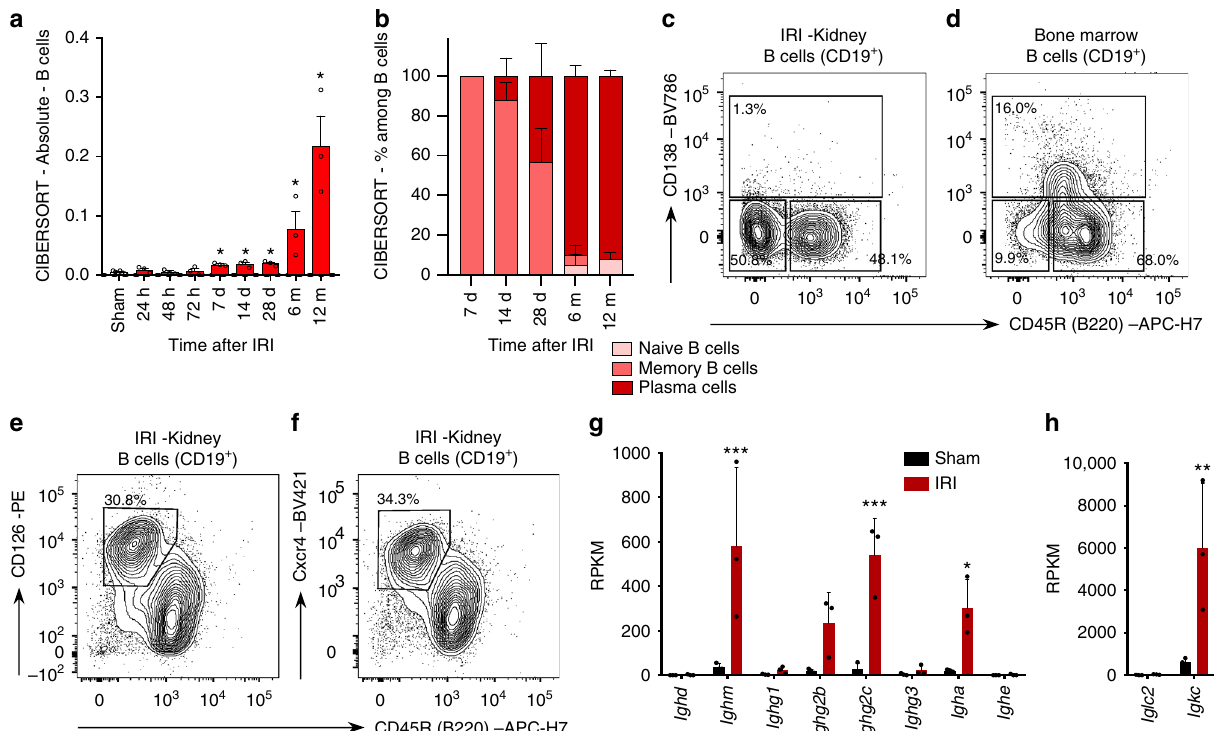
Fig. 4 B lymphocytes in the late phase after ischemia-reperfusion injury in mice. a , b Semi-quantitative evaluation of immune cell in fi ltrates in the kidney at different time points after IRI or sham surgery as determined by CIBERSORT analysis on whole kidney RNAseq data ( n = 3/group, Mann – Whitney test in comparison to sham control, * P < 0.05). c – f Flow cytometric analysis on CD45 + CD3 − CD19 + ordim leukocytes isolated from the kidney or the bone marrow (BM) 16 – 18 months after IRI (1 representative example of 6 replicates is shown). General gating strategy is presented in Supplementary Fig. 5. c , d CD138 was absent on renal B cells, but detectable on the bone marrow B cells isolated from the same mouse (additional controls presented in Supplementary Fig. 3). e , f CD45 + CD3 − CD19 + or dim CD45R − B cells expressed high levels of CD126 and CD184 ( Cxcr4 ). g , h RPKM values from RNAseq analysis on whole kidney 12 months after IRI or in sham controls focused on immunoglobulin constant regions transcripts ( n = 3/group, Sidak ’ s multiple comparison test, *adjusted- P < 0.05, ***adjusted- P < 0.001). In all histograms, mean values and SE are